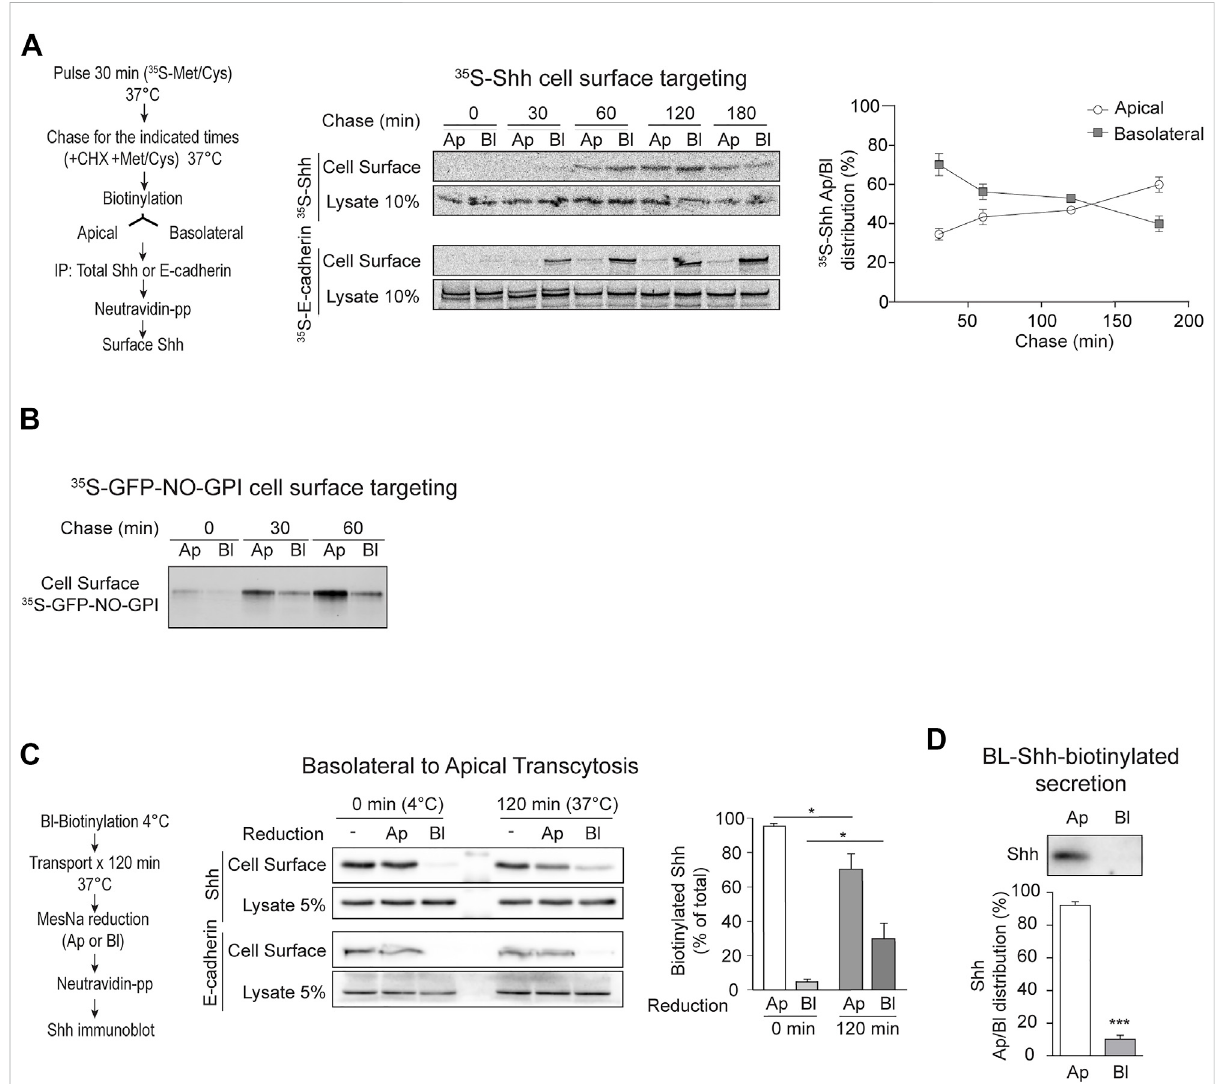
FIGURE 2 ApicalsortingofnewlysynthesizedShhisindirectthroughtranscytosis. (A) CellsurfacetargetingassayofnewlysynthesizedShhandE-cadherin in polarized MDCK-Shh cells grown in Transwell fi lters. The cells were pulse-labeled with 35 S-methionine/cysteine and chased at 37 ° C for the indicated times by subsequent cell-surface-speci fi c biotinylation at 4 ° C. S 35 -Shh is fi rst detected at the basolateral cell surface and then gradually increased at the apical domain, while S 35 -E-cadherin remains basolateral. Graph shows the relative distribution of S 35 -Shh at different time points (30 ′ , n = 5; 60 ′ , n = 7; 120 ′ , n = 4; and 180 ′ , n = 2). (B) Cell surface targeting assay of newly synthesized GPI-anchored protein (GFP-NO-GPI) shows direct apical sorting. (C) Shh basolateral-to-apical transcytosis assay. Filter-grown MDCK-Shh cells were basolaterally labeled at 4 ° C with reducible biotin linkage (NHS-SS-Biotin), incubated at 37 ° C for 120 min and then subjected to MesNa reduction at apical or basolateral sides. Shh- biotin, but not E-cadherin – biotin, decreased by reduction at the apical side indicating Shh transcytosis. Graph shows percentage of Shh-biotin after reduction (n = 3; mean ± SEM; unpaired t -test; * p < 0.05). (D) Basolateral cell surface Shh becomes apically secreted. MDCK-Shh cells biotinylated from the basolateral side at 4 ° C and then incubated at 37 ° C for 2 h mainly release biotinylated Shh toward the apical media. Graph shows the percentage of total secreted biotinylated Shh precipitated with NeutrAvidin – Agarose beads followed by immunoblot (n = 4; mean ± SEM; unpaired t -test; *** p <